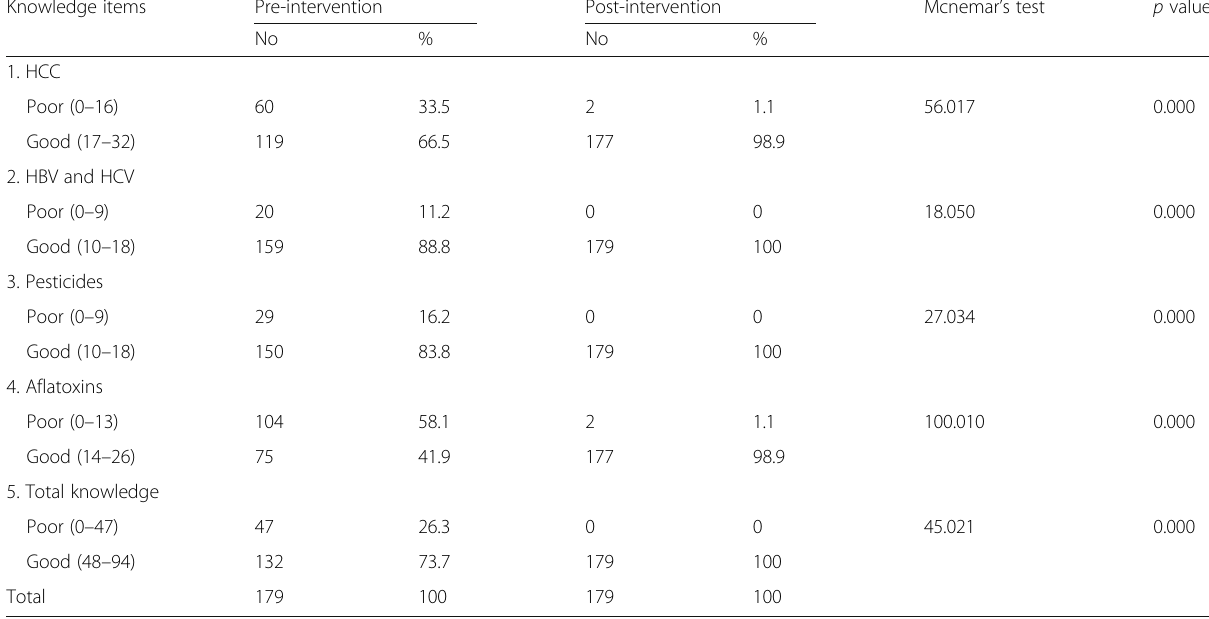
Table 2 Effect of health education intervention on participant ’ s knowledge about HCC, HBV, and HCV, pesticides, aflatoxins, and total knowledge Knowledge items